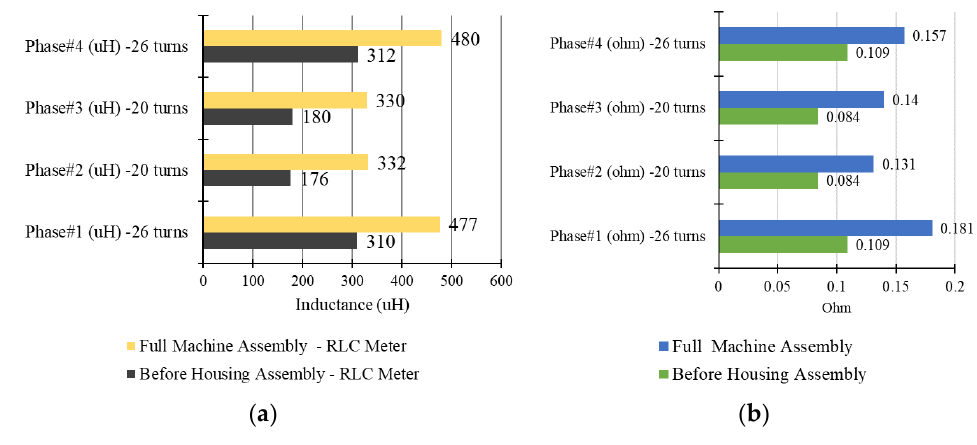
Figure 15. 4-phase TFM measured phase inductance ( a ), and resistance ( b ).